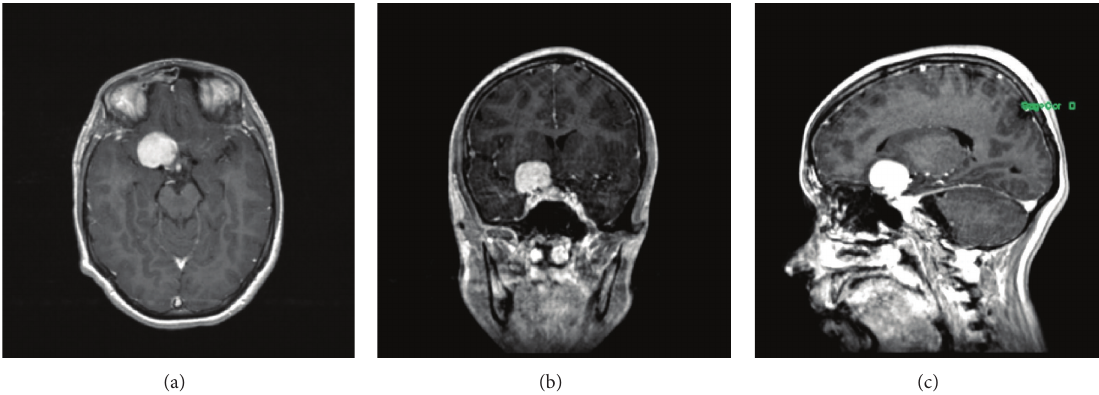
Figure 1: (a) Axial, (b) coronal, and (c) sagittal T1-weighted MRI showing a homogenously enhancing lesion, measuring 2.9 × 3.0 × 2.0 cm in the right clinoidal region. There is probable extension into the right optic canal, sphenoid sinus, right temporal fossa, and possibly right cavernous sinus, suggestive of a right clinoidal meningioma.